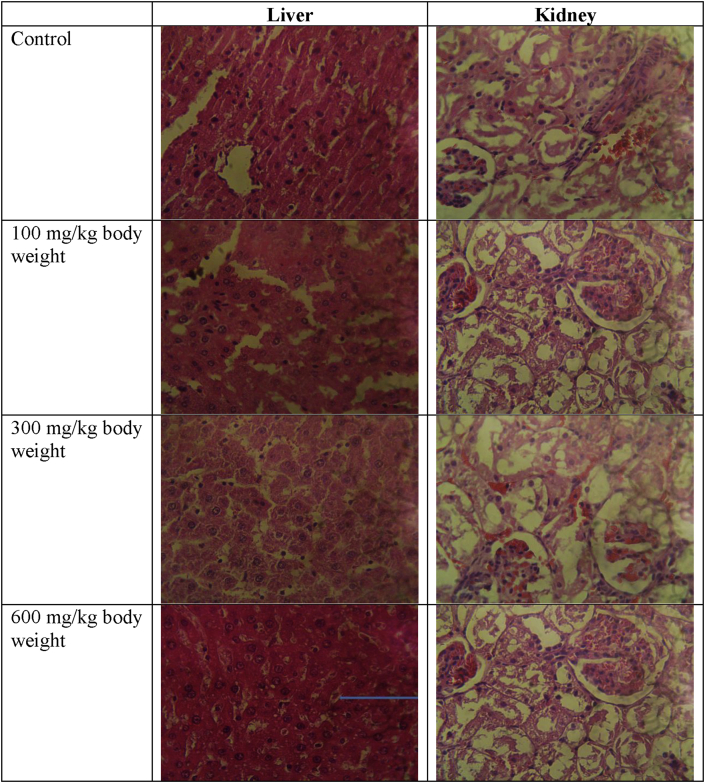
Photomicrograph of sections of liver and kidney in control and treated groups (H & E ×400). The liver section at 600 mg/kg shows mild degeneration of hepatocytes (thin arrow). Other sections of the liver were similar to the control. The sections of the kidney of the treated groups were similar to the control with normal glomerulus.